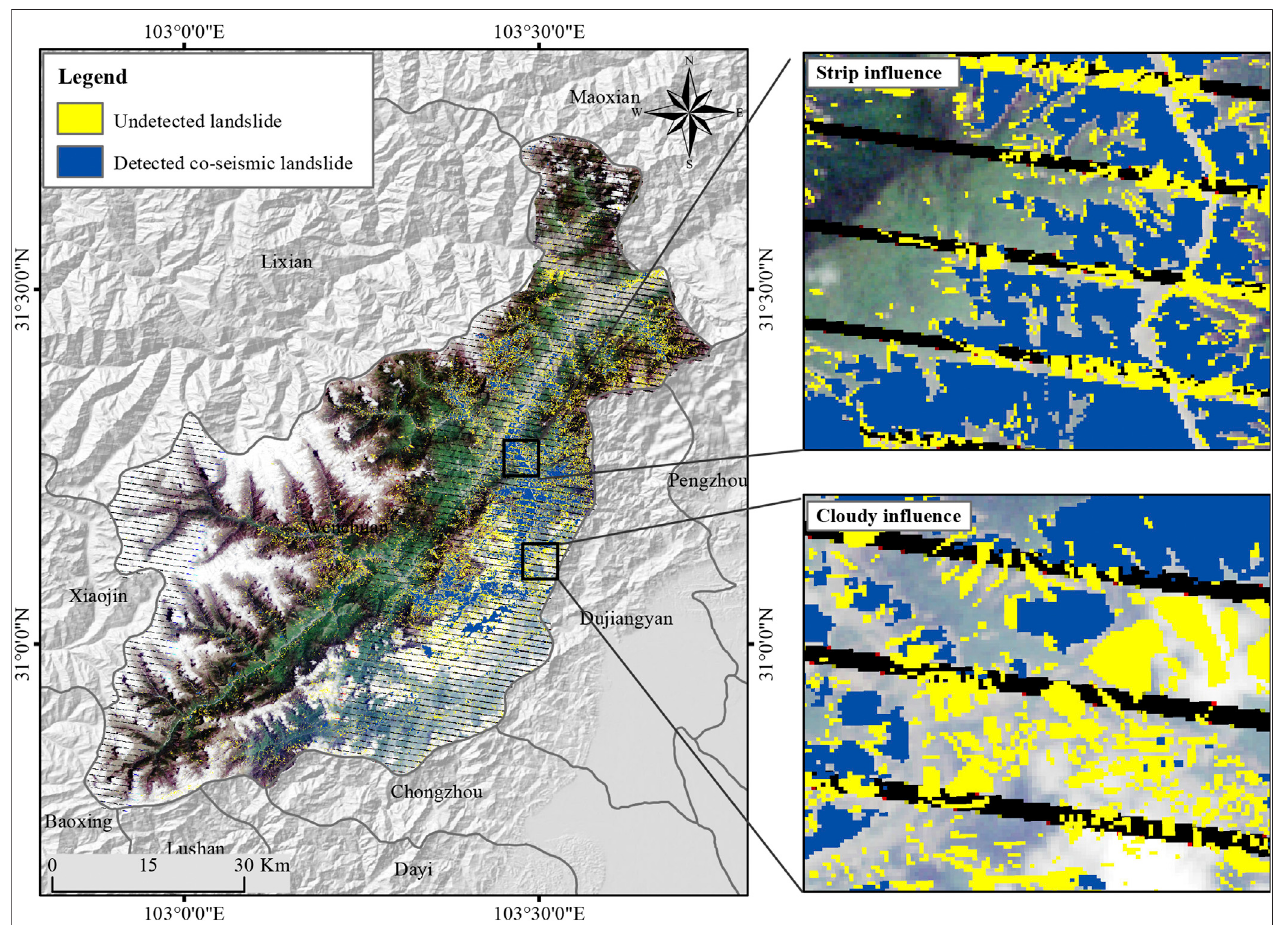
FIGURE 3 | The incomplete LIM extracted from multi-temporal Landsat images.